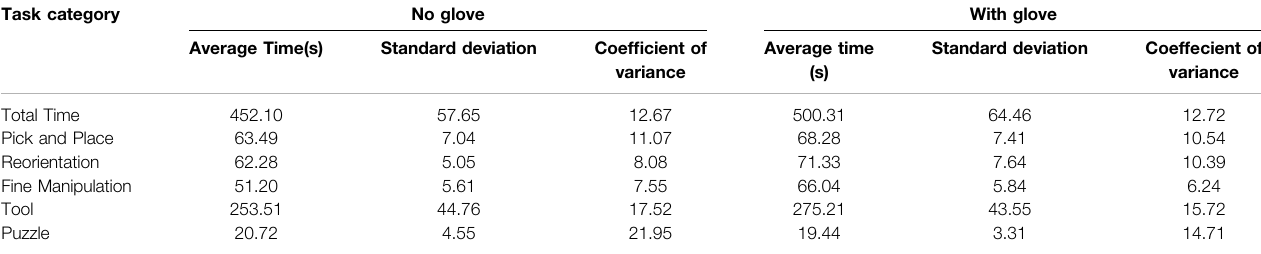
TABLE 4 | Table presenting the baseline scores for the dexterity tests performed by a human with a glove and without a glove. Task category With